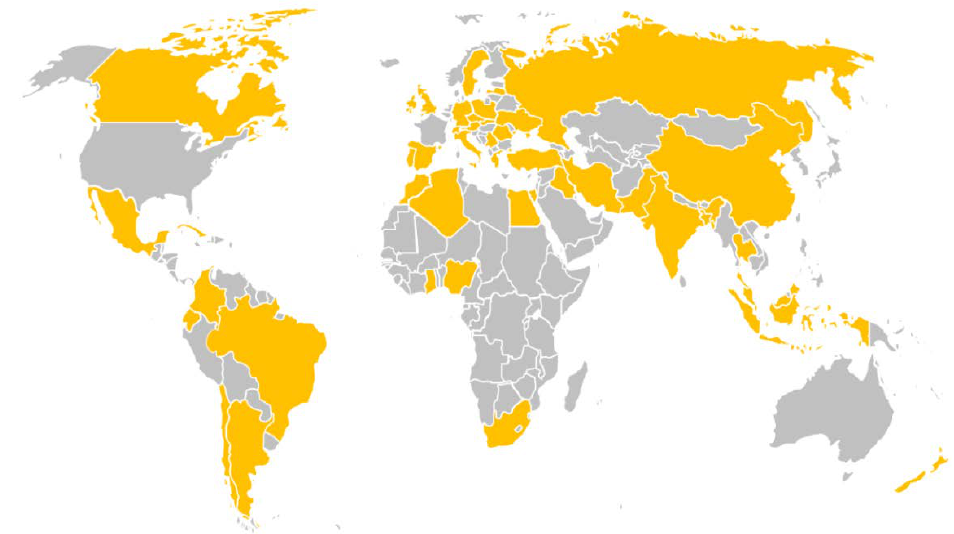
Figure 5. Countries affiliations of the authors that addressed recently the IMSs research